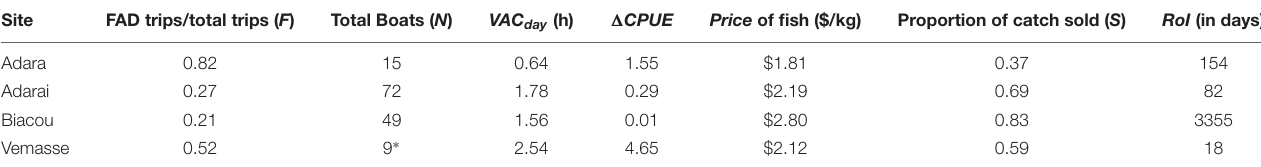
TABLE 4 | Site-based Returns on Investment ( RoI ) in days for nearshore FADs at four sites in Timor-Leste.